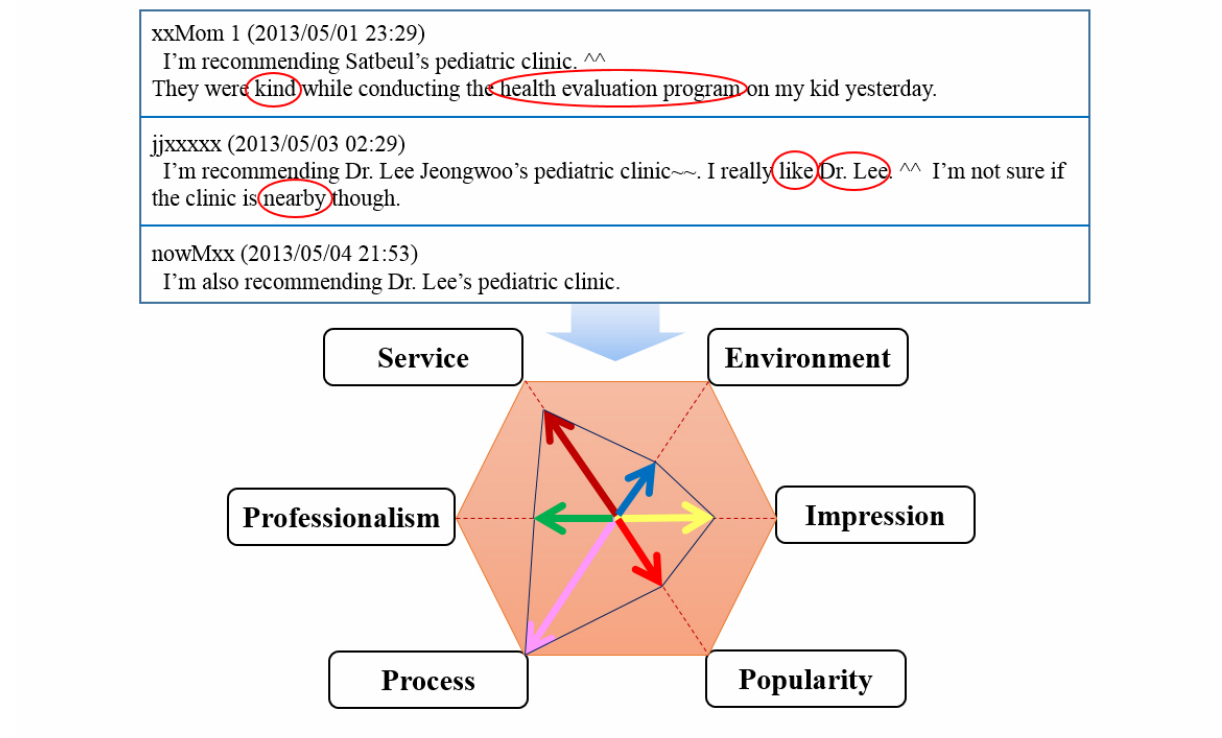
Figure 3. Social media-based key quality factors for